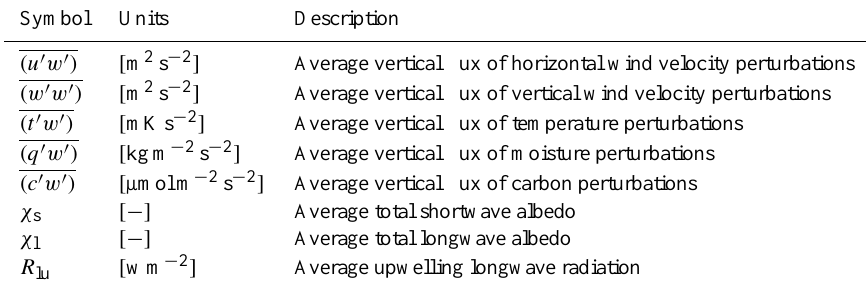
Table A2. ED2 flux variables providing the lower boundary condition for the BRAMS atmospheric